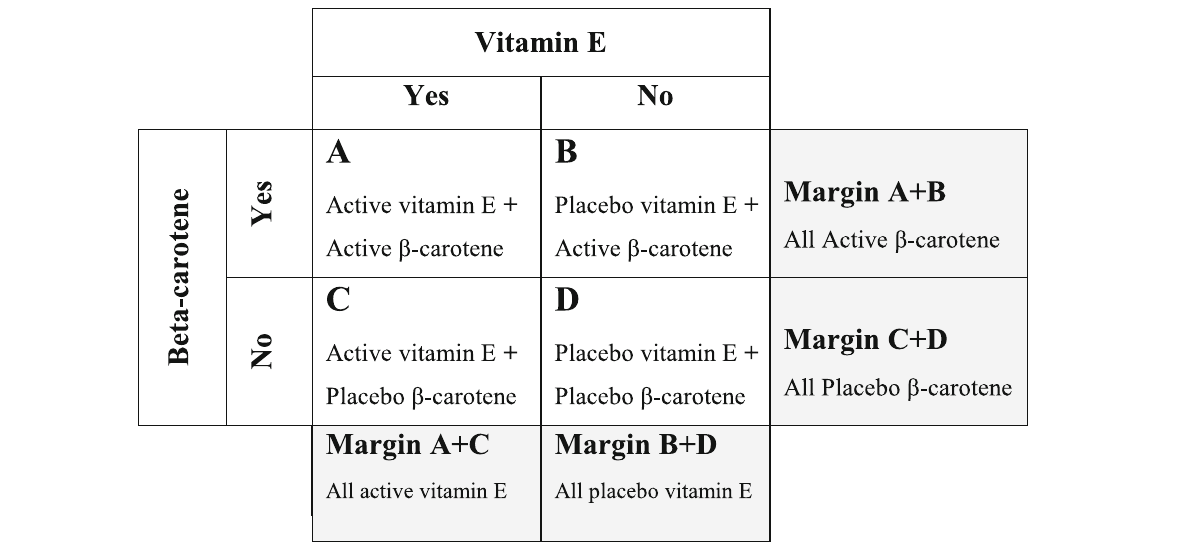
Table 1 “ At the margins ” (4 cell) and “ inside the cell ” (2 cell) factorial design analysis